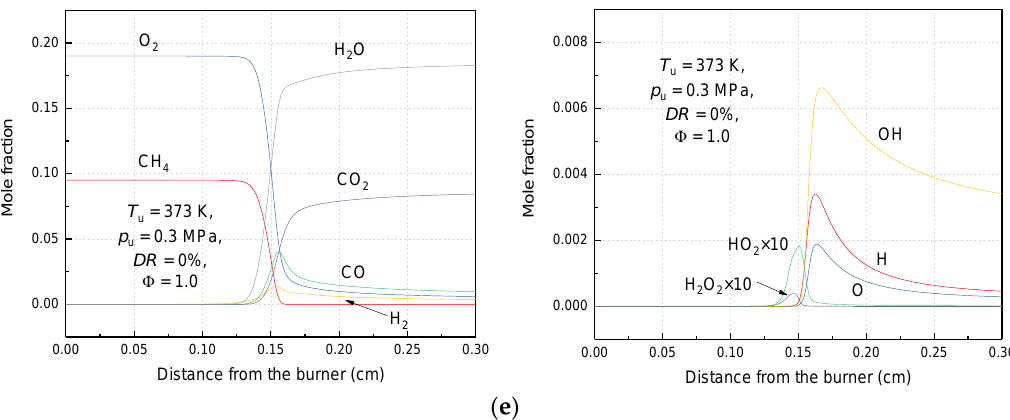
Figure 8. Flame structures under di ff erent initial pressures. ( a ) T u = 373 K, p u = 0.1 MPa, DR = 0%, Φ = 1.0; ( b ) T u = 373 K, p u = 0.15 MPa, DR = 0%, Φ = 1.0; ( c ) T u = 373 K, p u = 0.2 MPa, DR = 0%, Φ = 1.0; ( d ) T u = 373 K, p u = 0.25 MPa, DR = 0%, Φ = 1.0; ( e ) T u = 373 K, p u = 0.3 MPa, DR = 0%, Φ = 1.0.